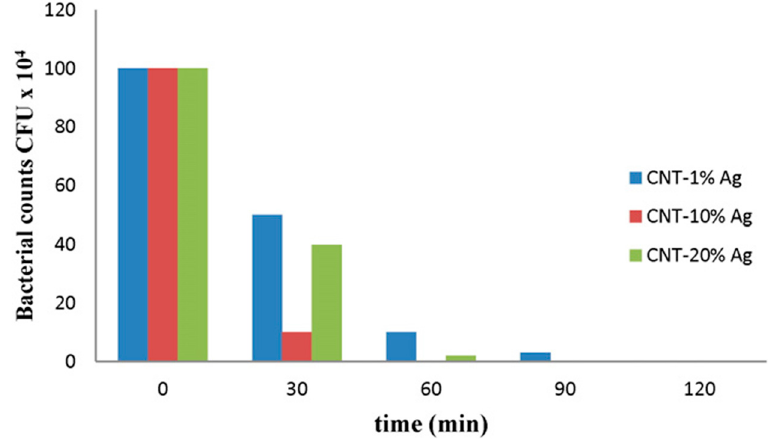
Figure 7. Effect of time on the amount of bacteria remaining in the filtrate (expressed as colony forming units (CFU)) after passage across Ag/MWNT membranes with different loadings of silver. Reproduced with permission from Reference [84]. Copyright Elsevier, 2015.